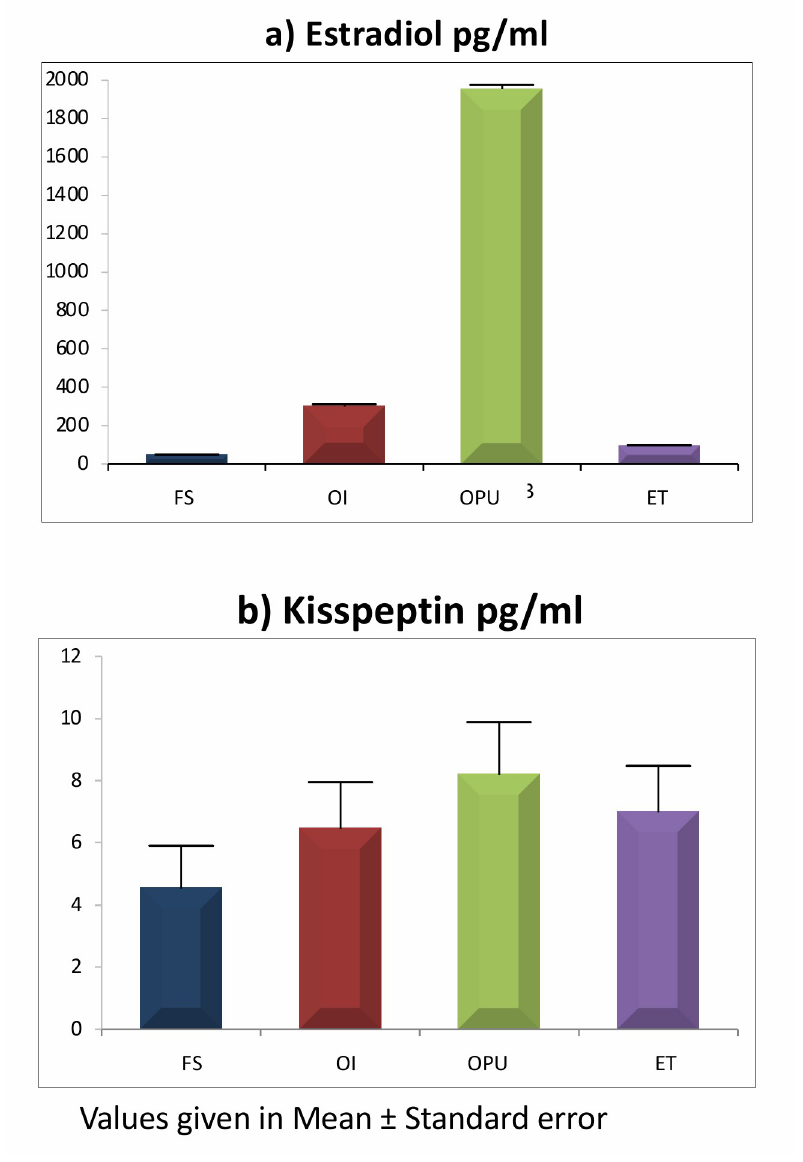
Fig 2. Comparison of estradiol (a) and kisspeptin (b) in all stages of stimulation. � Significant with stage 1 at 0.05 �� Significant with stage 1 at 0.01. Stage 1, FS: Follicular stimulation, Stage 2, OI: Ovulation Induction, Stage 3, OPU: Oocyte pickup, Stage 4, ET: Embryo